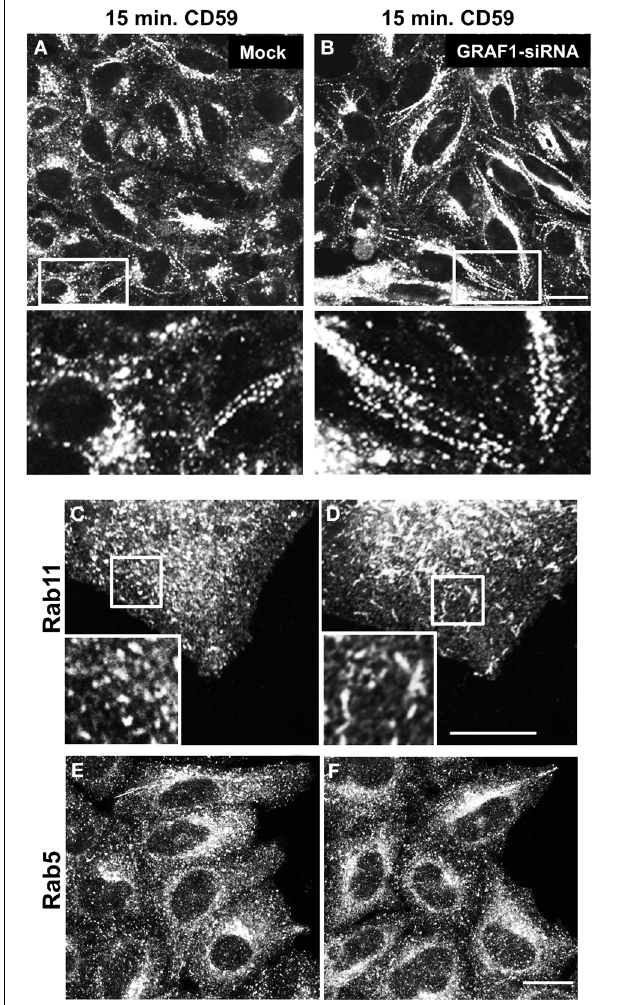
FIGURE 4 | GRAF1-depletion induces hyper-tubulation of CD59-containing endosomes and Rab11-positive recycling endosomes. Cells grown on coverslips were either mock-treated (A,C,E) or treated with GRAF1-siRNA (B,D,F) for 72h. (A,B and insets ) Cells were incubated with mouse anti-CD59 antibody for 15min. At 37 ◦ C, followed by a 1min. acid stripping and fixation. Fixed cells were stained with Alex 568-goat anti mouse secondary antibody. After siRNA-treatment, cells were fixed and stained with either anti-Rab11 antibody (C,D) or anti-Rab5 antibody (E,F) , followed by appropriate secondary antibodies. Bar, 10 μ